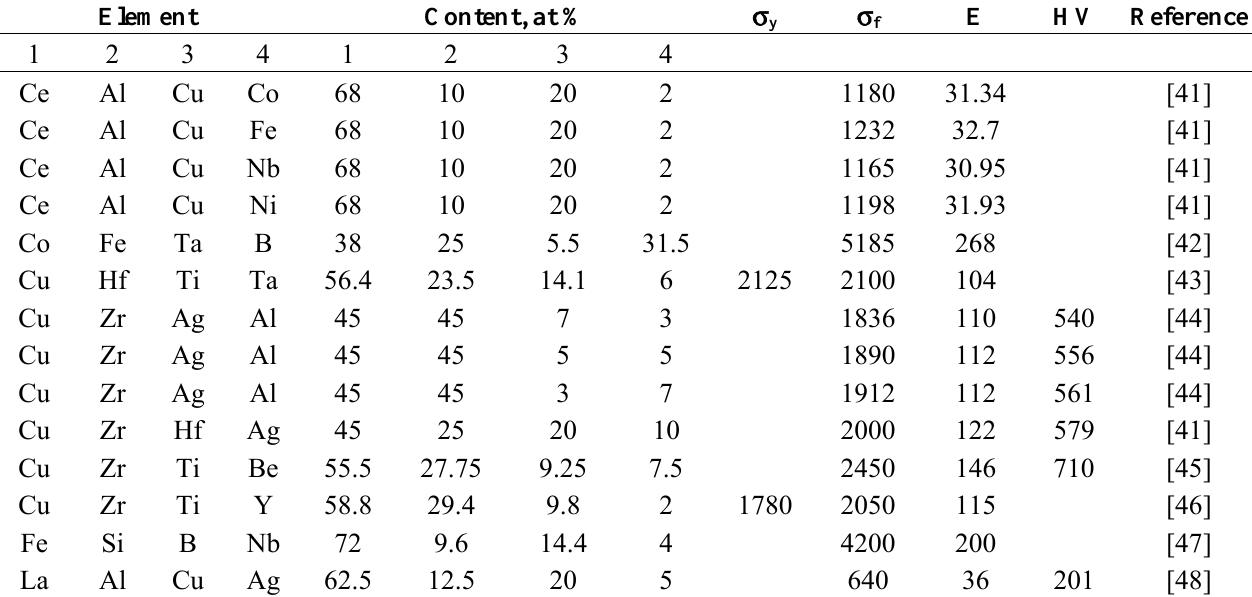
Table 2. Composition and mechanical properties of quaternary bulk glassy alloys.